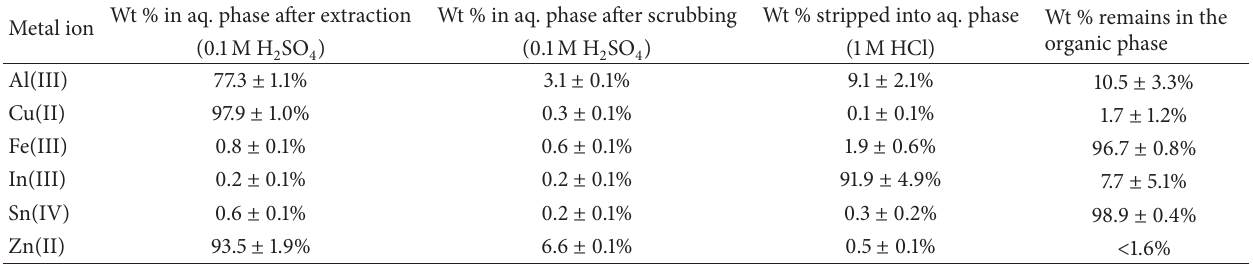
Table 7: Single stage batch test of extraction, washing, and stripping. Aqueous phases were 0.1M H HCl (stripping). The organic phase was 0.25 M D2EHPA diluted in kerosene with 2% 1-decanol. Wt % in aq. phase after extraction Wt % in aq. phase after scrubbing Metal ion